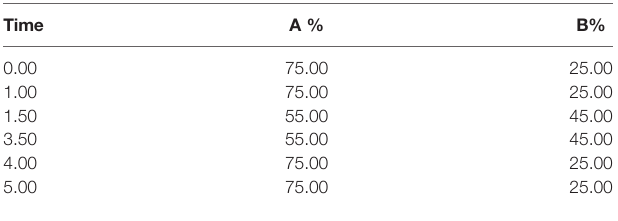
TABLE 2 | The LC gradient elution.